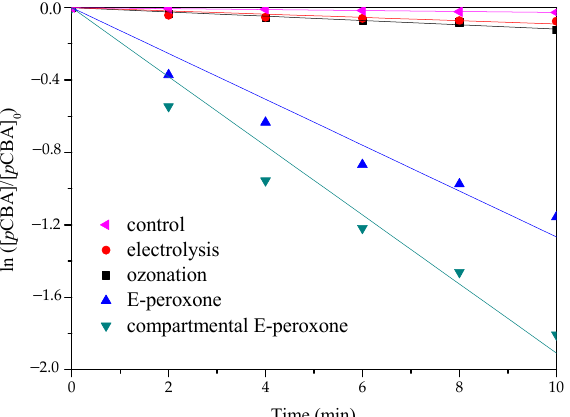
Figure 5. Time-dependent decay of p CBA in various treatment processes. (Gas flow rate = 0.2 L/min; Inlet O 3 concentration = ~20 mg/L; Applied current = 20 mA/cm 2 ; Temperature = 25 ± 2 °C).